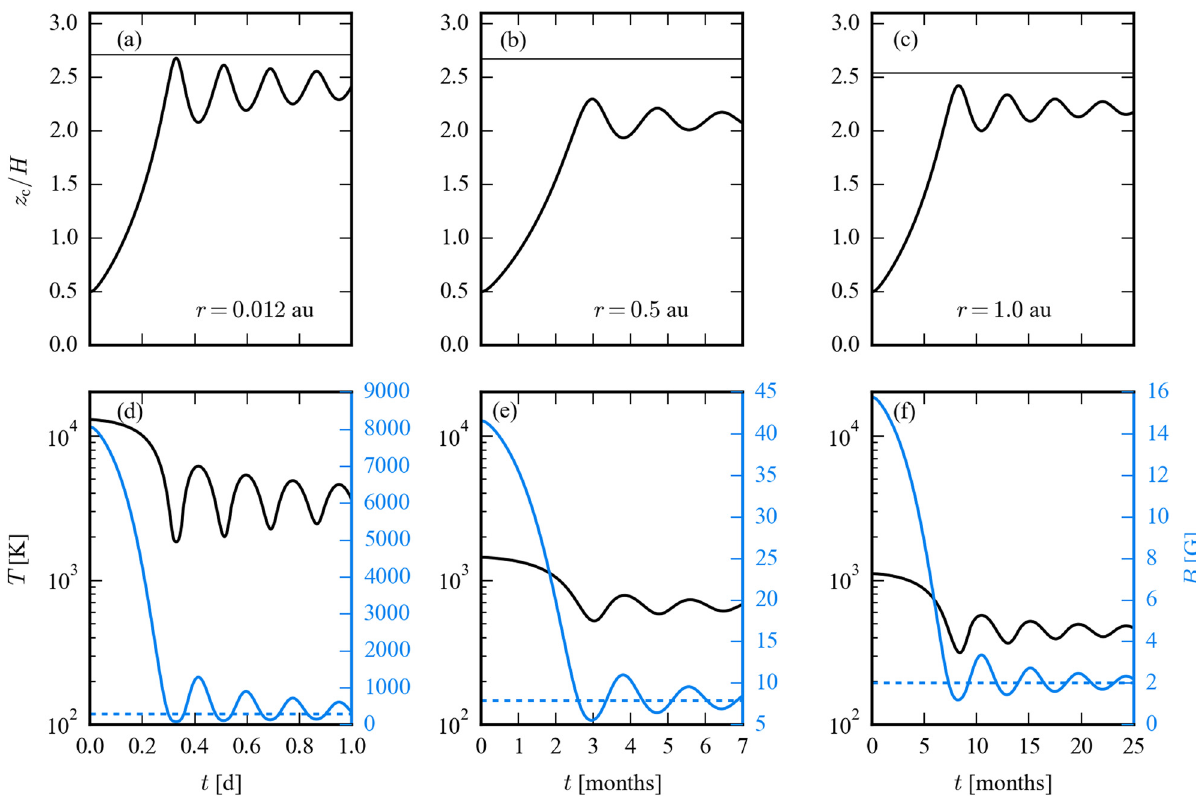
Figure 6: Dynamics of the MFTs at di ff erent r in the presence of external magnetic fi eld. Top row: the dependence of the z - coordinate of the MFT on time during its motion inside the disk at various radial distances r 0.012 = , 0.15, and 1 au ( panels a, b, and c, respectively ) . Horizontal lines show the surface of the disk. Bottom row ( panels d, e, and f, respectively ) : corresponding dependences of temperature ( left y - axis, black lines ) and magnetic fi eld strength ( right y - axis, blue lines ) on time. Horizontal dashed blue lines correspond to the external magnetic fi eld B e . Initial radius and plasma beta of the MFT are a H 0.1 0 = and β 1 , 0 =